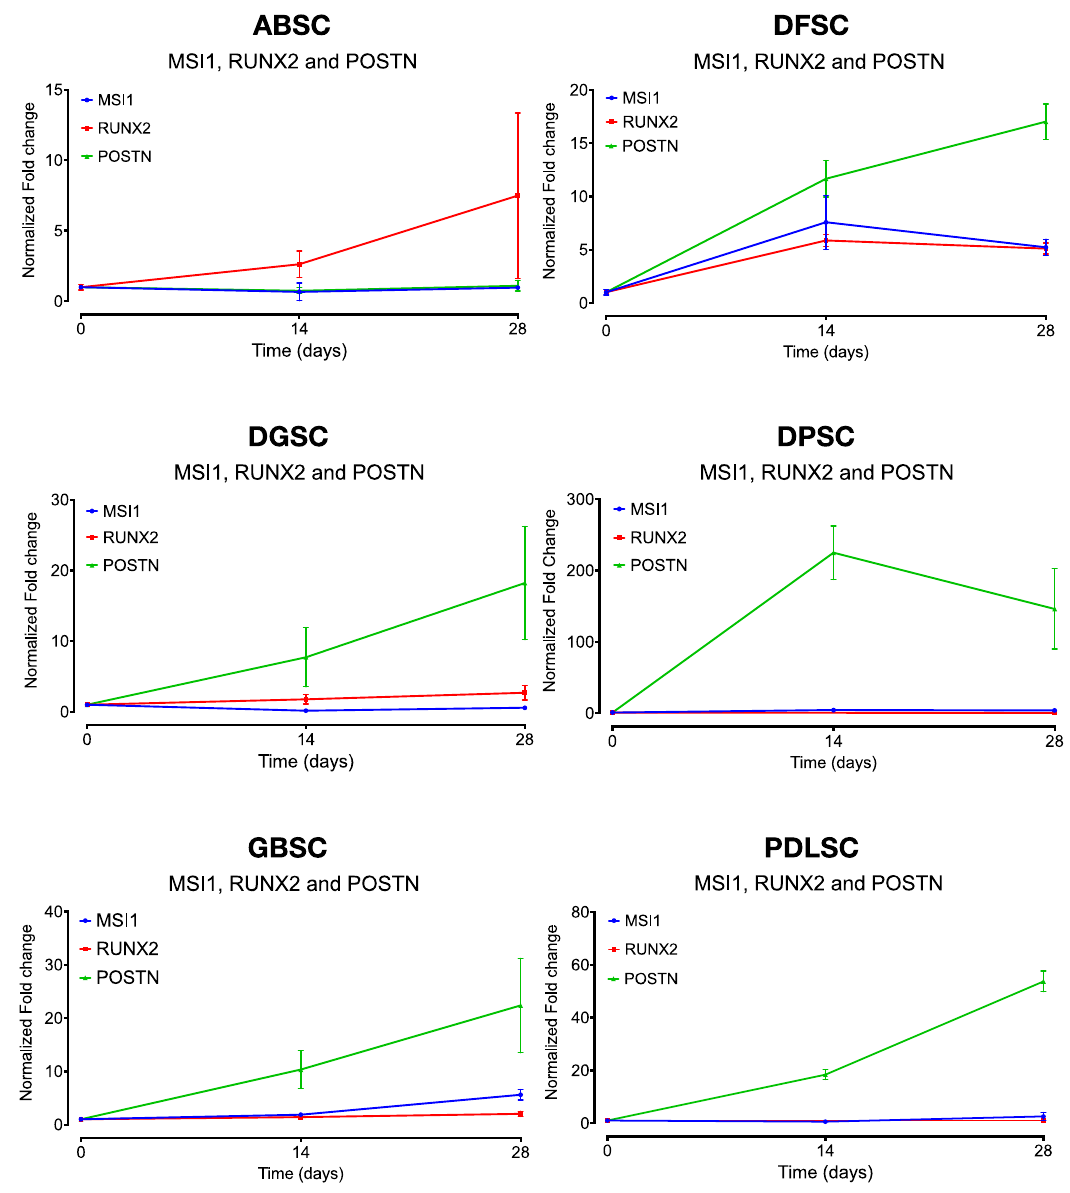
Figure 8. Comparative expression (fold change normalized to day 0) of MSI1, RUNX2, and POSTN over time by each cell population under osteogenic conditions. Data are shown as mean(SD).